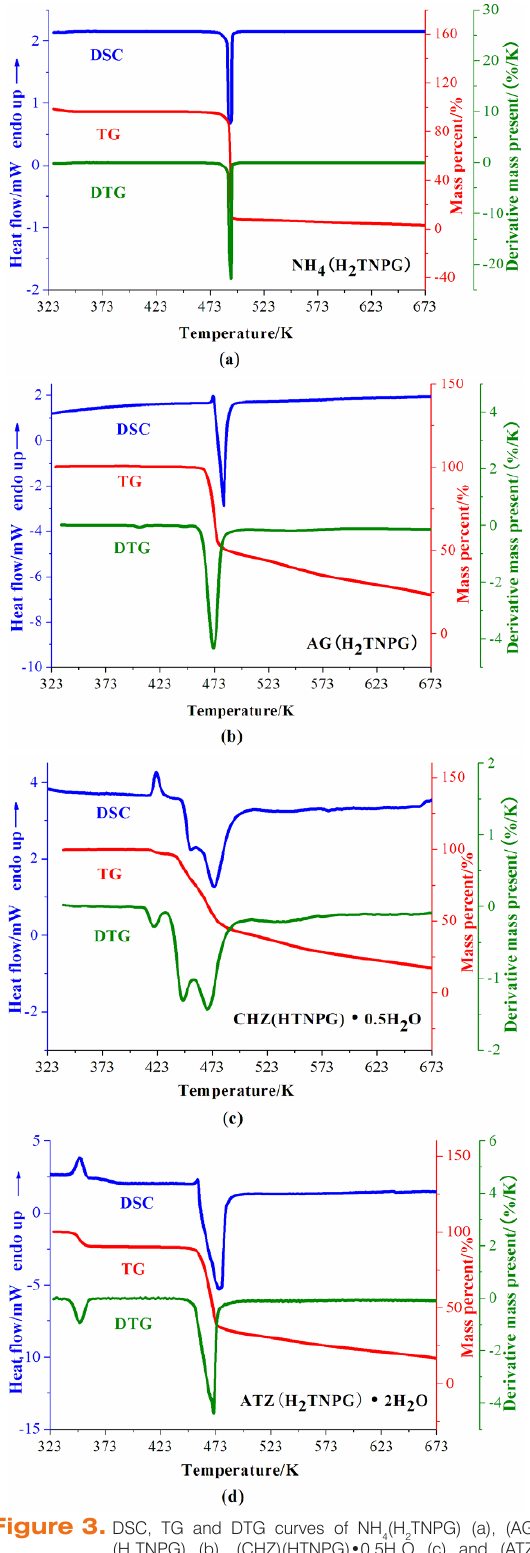
(H TNPG) (a), (AG) 4 2